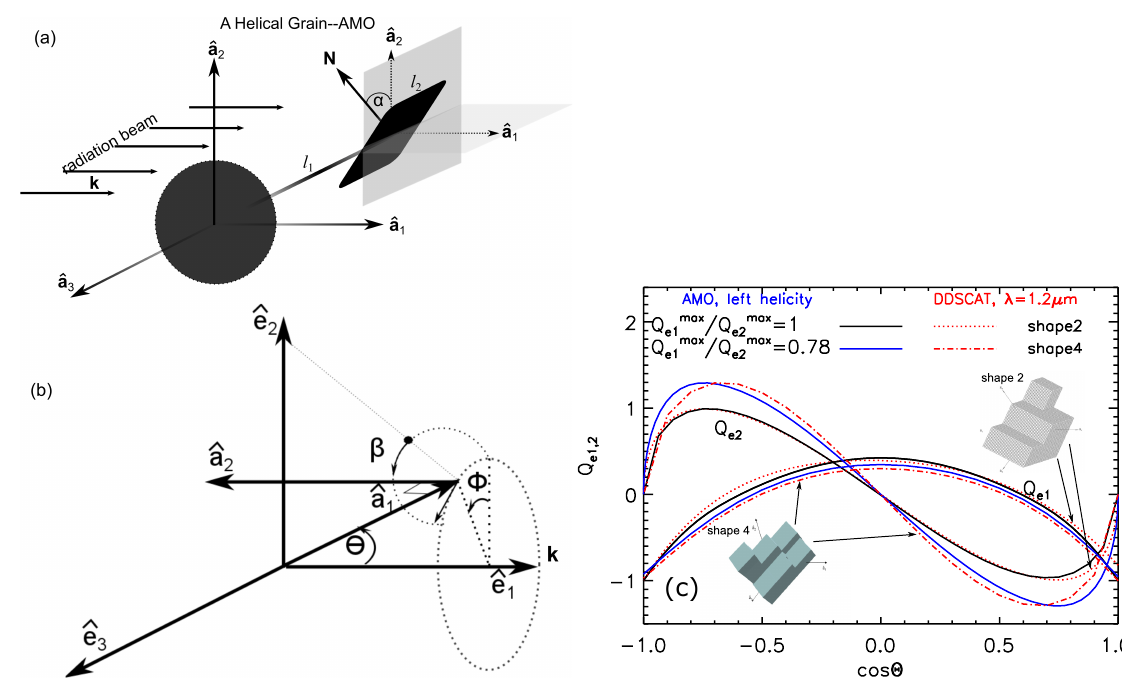
Figure 1. Panel ( a ): A helical grain model described by three principal axes, ˆ a 1 ˆ a 3 ˆ a 3 , proposed by Lazarian and Hoang [29] to calculate analytically Radiative Torques (RATs), comprising an oblate spheroid and a massless mirror attached to the spheroid. The normal vector of the mirror is titled by an angle α with respect to the principal axis ˆ a 2 . Panel ( b ): Scattering coordinate frame of reference used for calculations of RATs, described by three axes, ˆ e 1 ˆ e 2 ˆ e 3 where ˆ e 1 is defined along k , and ˆ e 2 ˆ e 3 form a plane perpendicular to ˆ e 1 . Θ is the angle between the axis of maximum moment of inertia, ˆ a 1 , with the radiation direction k , Φ is the precession angle of ˆ a 1 around k , and β is the angle that describes the rotation of the grain around ˆ a 1 . Panel ( c ): comparison of the functional form of RATs from AMO and numerical computation using DDSCAT. From Lazarian and Hoang [29].